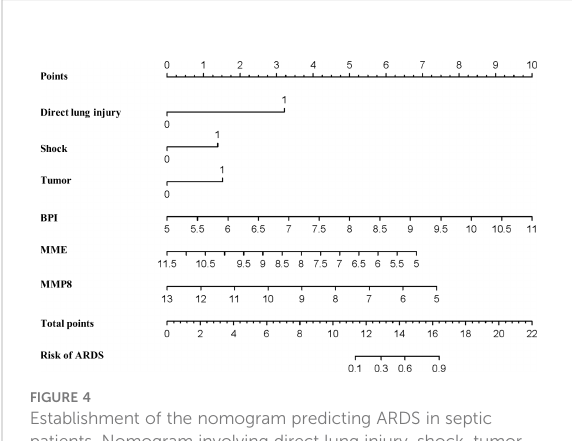
FIGURE 4 Establishment of the nomogram predicting ARDS in septic patients. Nomogram involving direct lung injury, shock, tumor, BPI, MME and MMP8 was visualized and applied for the prediction of ARDS among critically ill patients with